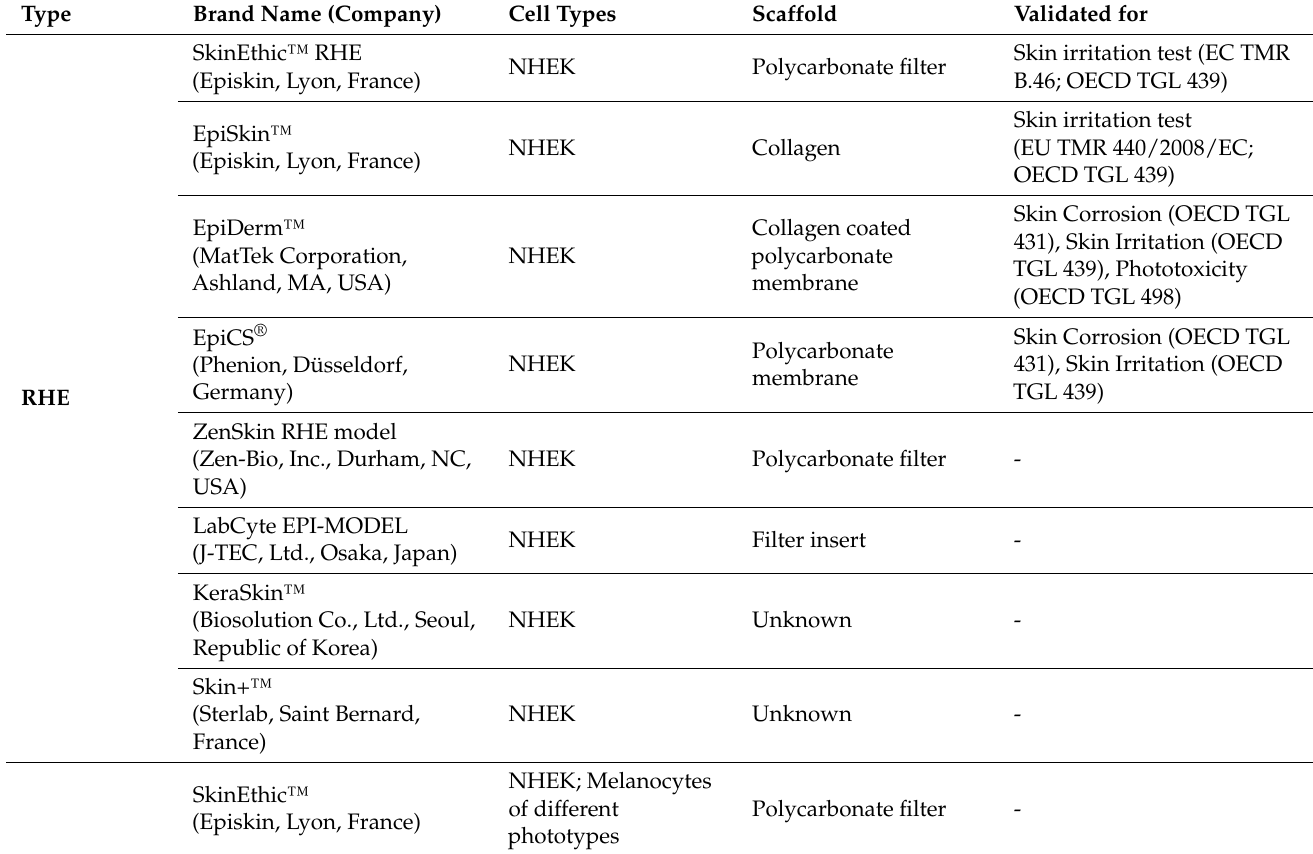
Table 1. Commercially available human skin